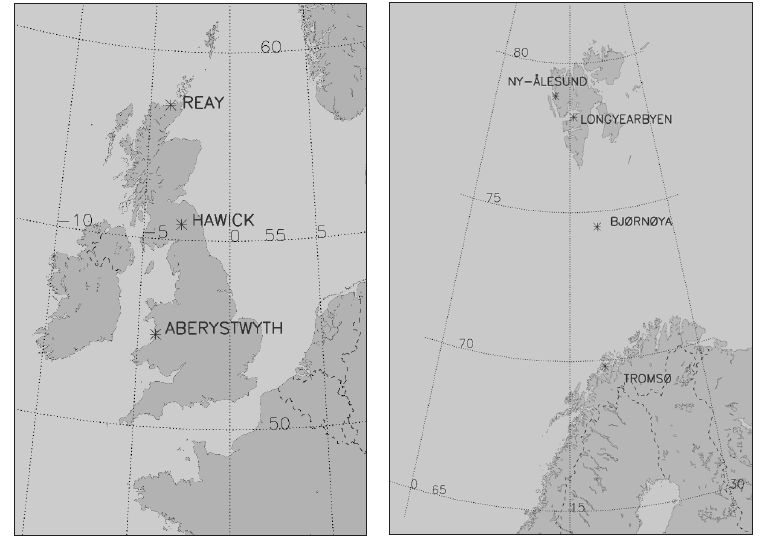
Fig. 1. Maps showing locations of satellite receiving station chains in U.K. and Scandinavia currently in use by UWA